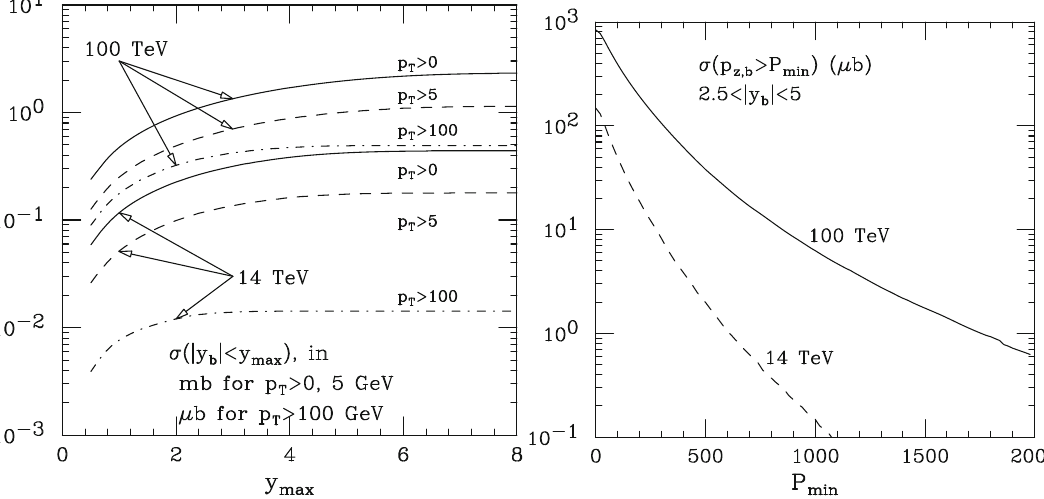
Fig. 7.4 Left: production rates for b quarks as a function of detection acceptance in y , for various p T thresholds (rates in μ b for p T > 100 GeV, in mb otherwise). Right: forward b production rates, as a function of the b longitudinal momentum